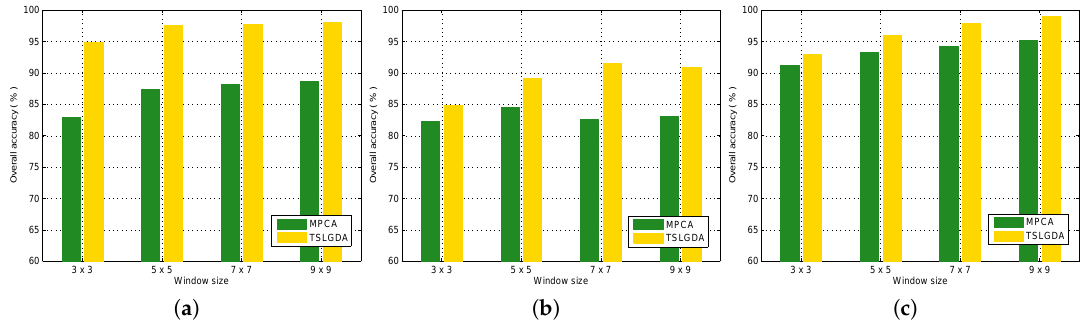
Figure 3. Parameter tuning of window size for MPCA and TSLGDA using three datasets: ( a ) Indian Pines; ( b ) University of Pavia; ( c ) Salinas.